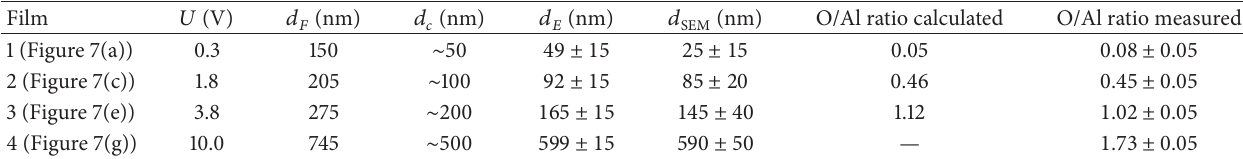
Table 2: Film thickness 𝑑 𝐹 calculated by Faraday’s law (on pure Al), film thickness 𝑑 𝑐 according to colour, film thickness 𝑑 𝐸 estimated by ellipsometry,filmthickness 𝑑 SEM measuredoncrosssections(allonENAW-7075T73),O/Alratioaccordingtothefilm/substratecontribution calculated using the EDS spectra, and O/Al ratio derived from EDS analysis as a function of the anodisation potential 𝑈 (Ag/AgCl